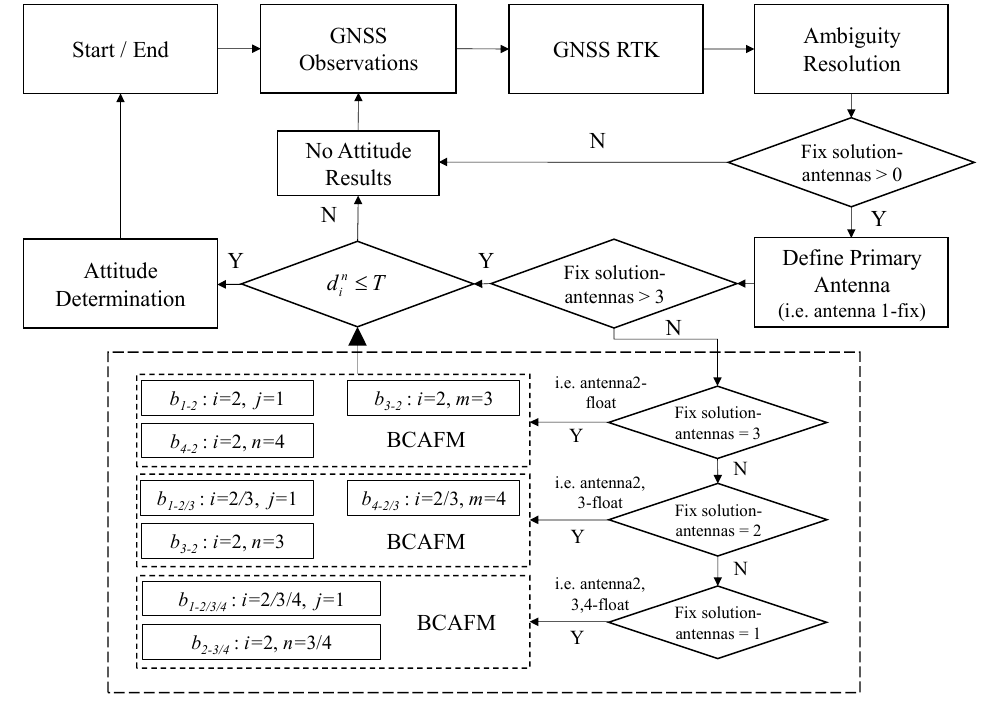
Figure 3. The workflow of the proposed method.